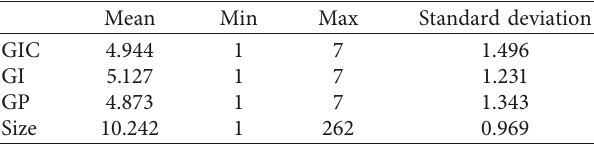
Table 3: Values of the mean, minimum value, maximum value, and standard deviation of the variables